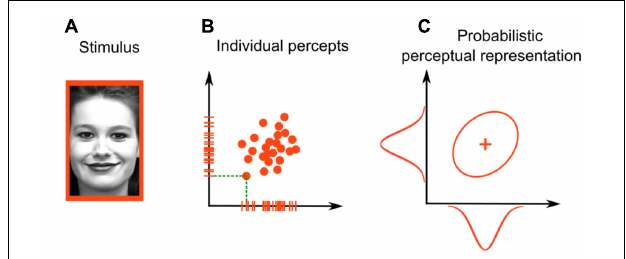
FIGURE 1 | Stimulus representation in general recognition theory. For (A) faces varying in gender (male or female) and emotional expression (sad or happy), the representation is two-dimensional. Each stimulus presentation produces (B) a point in the two-dimensional space. The whole distribution of such perceptual effects can be described through (C) a two-dimensional probability distribution. Face photograph in (A) obtained from the Extended Cohn-Kanade (CK+) database (S74, Jeffrey Cohn; Kanade et al., 2000; Lucey et al., 2010), consent for publication obtained by the original authors.